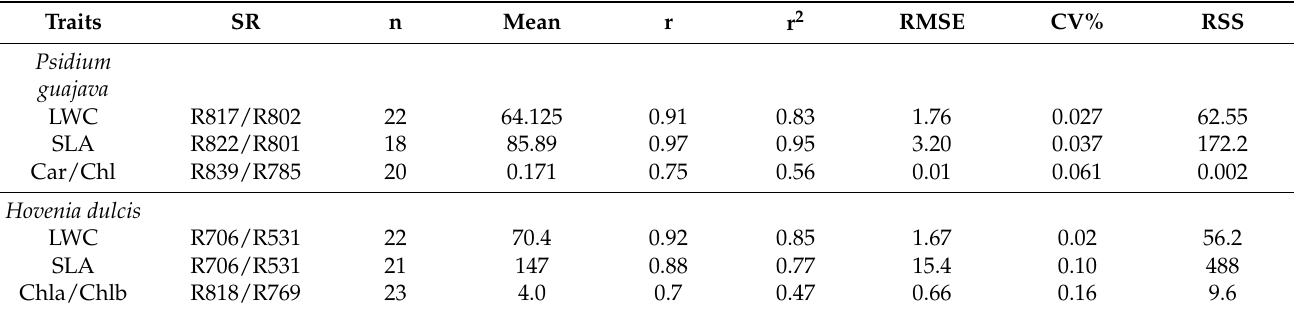
Table 10. Summary of the most-significant leaf optical properties and leaf characteristics of two invasive tree species in QCSP. LWC (%) = liquid water content; SLA (cm 2 .g − 1 ) = specific leaf area; Chla/Chlb = chlorophyll a:b ratio; Car/Chl = carotenoid:total chlorophyll ratio; SR= simple ratio, n = number of samples, r = simple ratio correlation; r 2 = coefficient of determination; RMSE = root mean square error; CV = coefficient of variation; RSS = residual sum of squares. Significant results at α = 0.01, and at a 99% confidence level ( p -value <